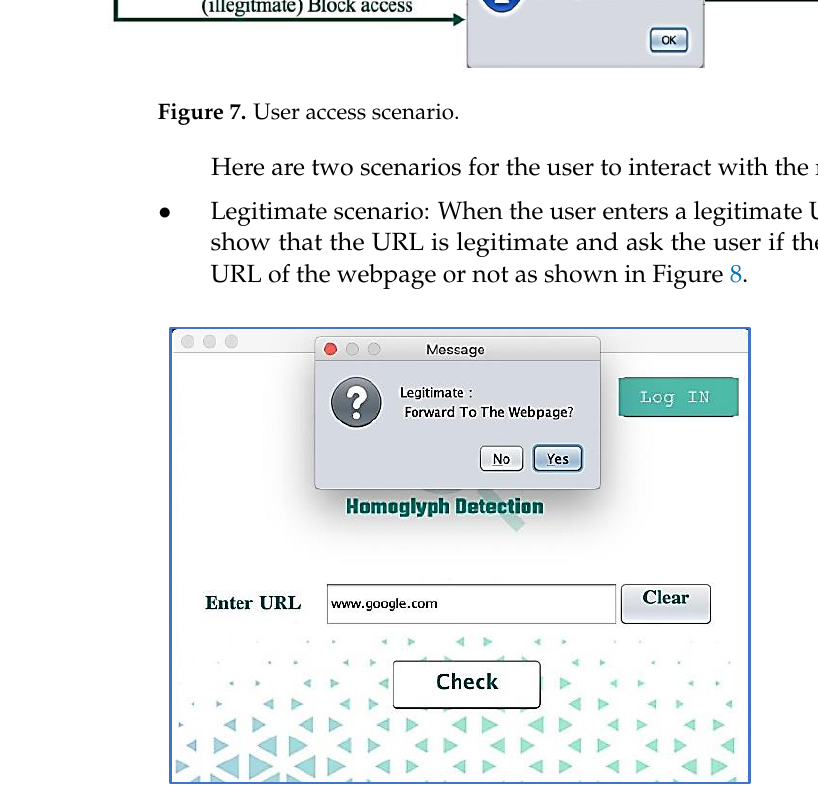
Figure 9. Phishing site . 3. Experimental Analysis, Observations, and Results This section provides a clear justification for what makes the homoglyph detector a better solution in terms of different criteria in Table 4. This will be completed through a comparison based on the following solution requirements. Table 4. Comparison with existing techniques. Scheme/Feature